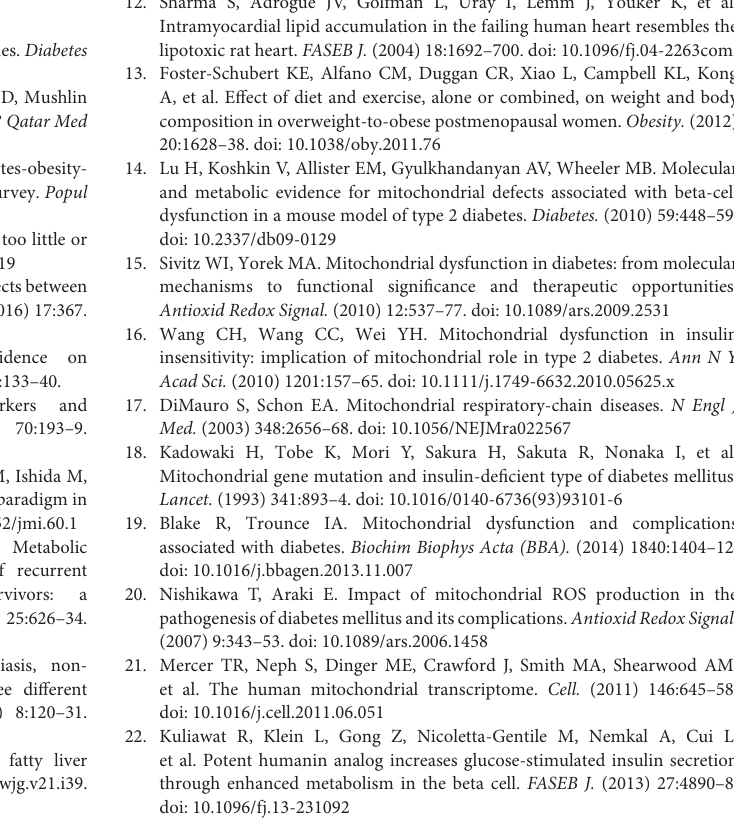
Newly diagnosed diabetes (diet and